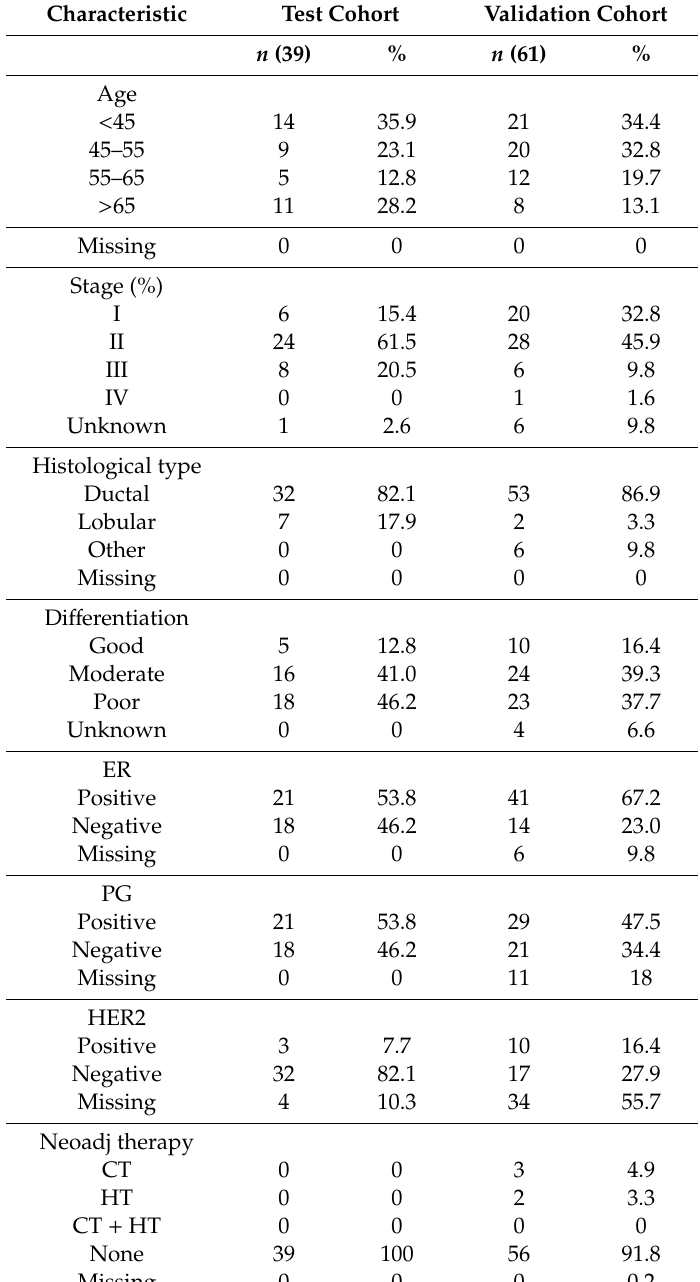
Table 2. Characteristics of subgroup of 100 breast cancer patients in test and validation cohort. Characteristic Test